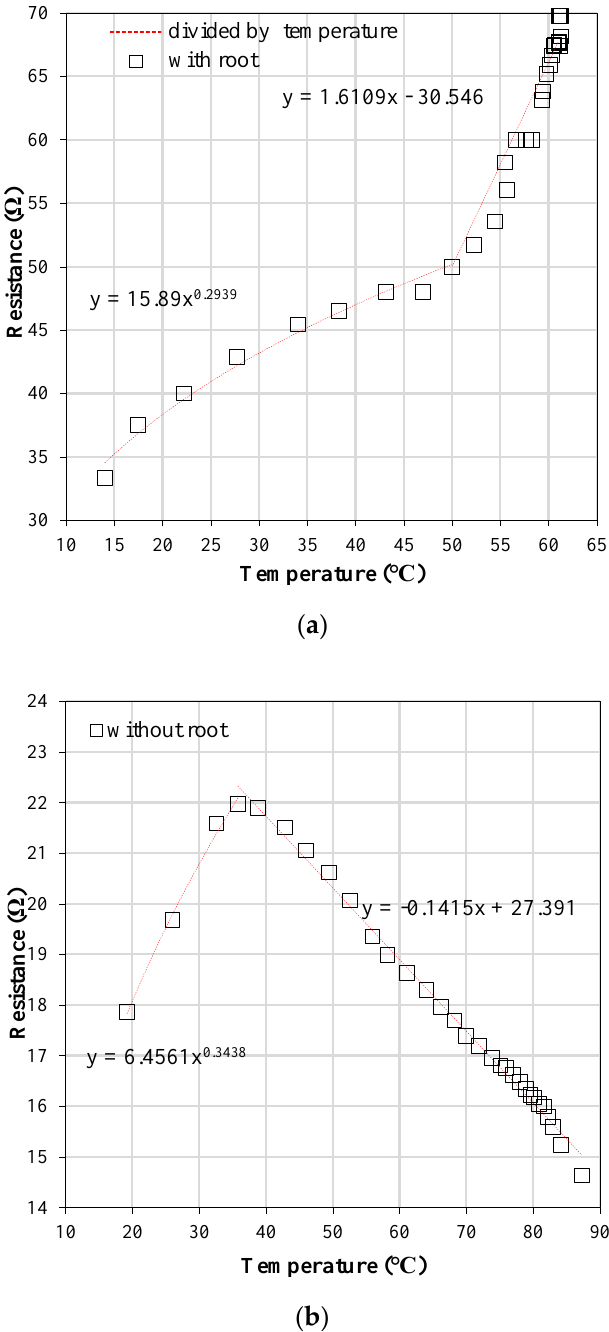
Figure 7. The variation of substrate resistance with the temperatures measured at Point 2; ( a ) comparison test—substrate with curing period of 175 days (with plant roots); ( b ) initial test—substrate with curing period of 0 days (without plant roots).